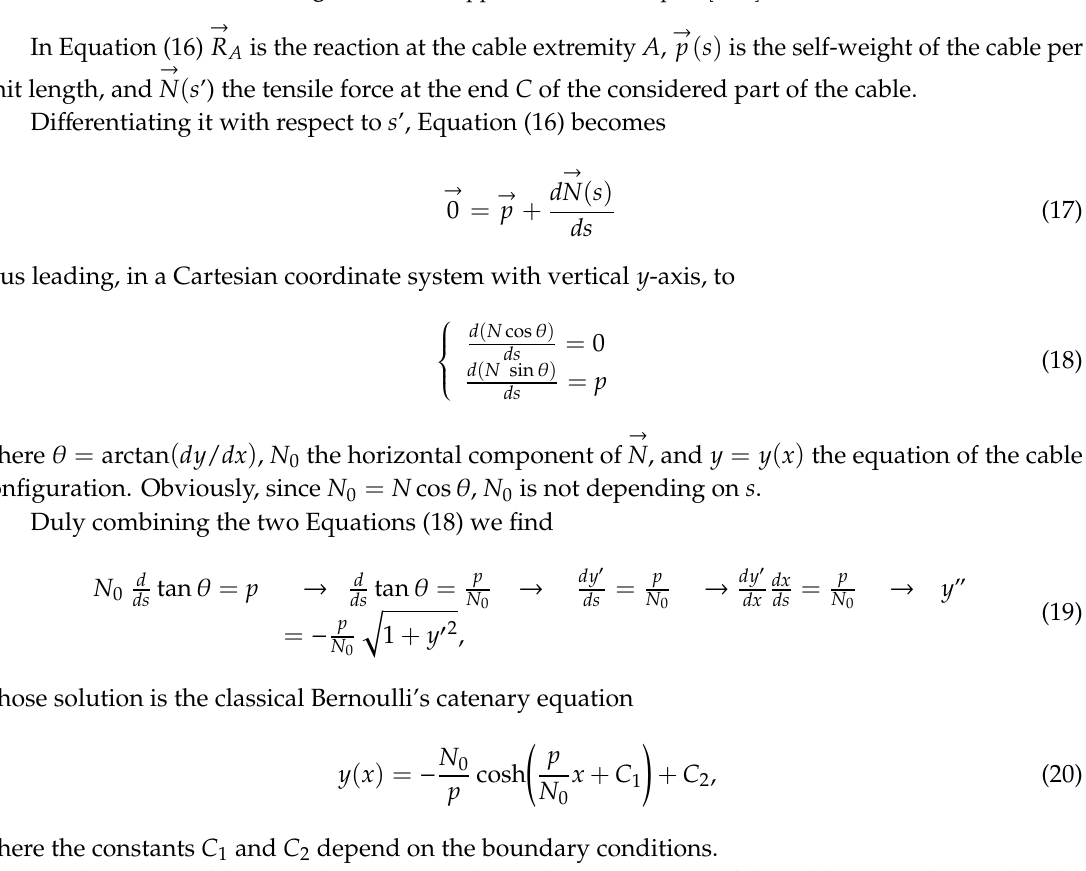
Figure 2. Loads applied on the cable part [ A , C ] .